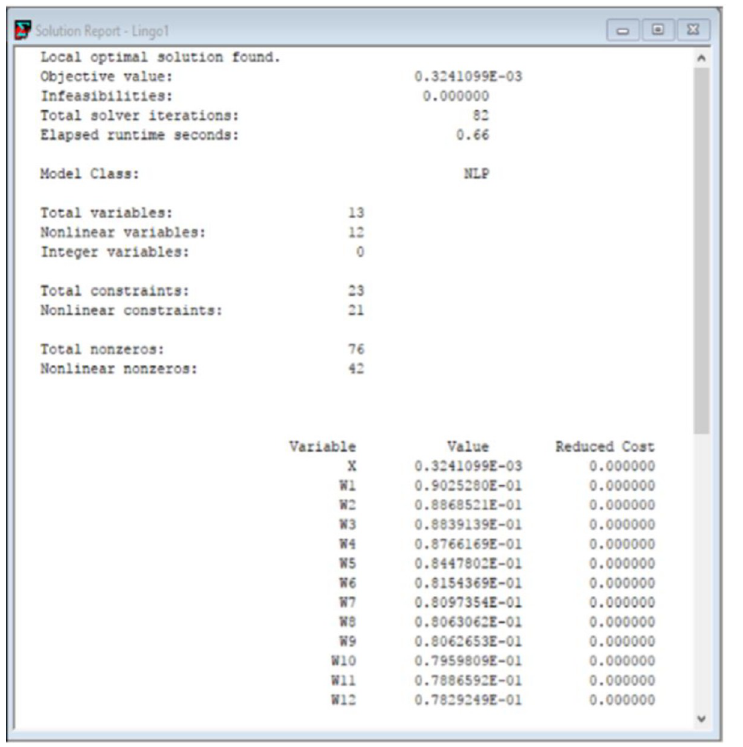
Fig 2. Optimal solution obtained from LINGO software.